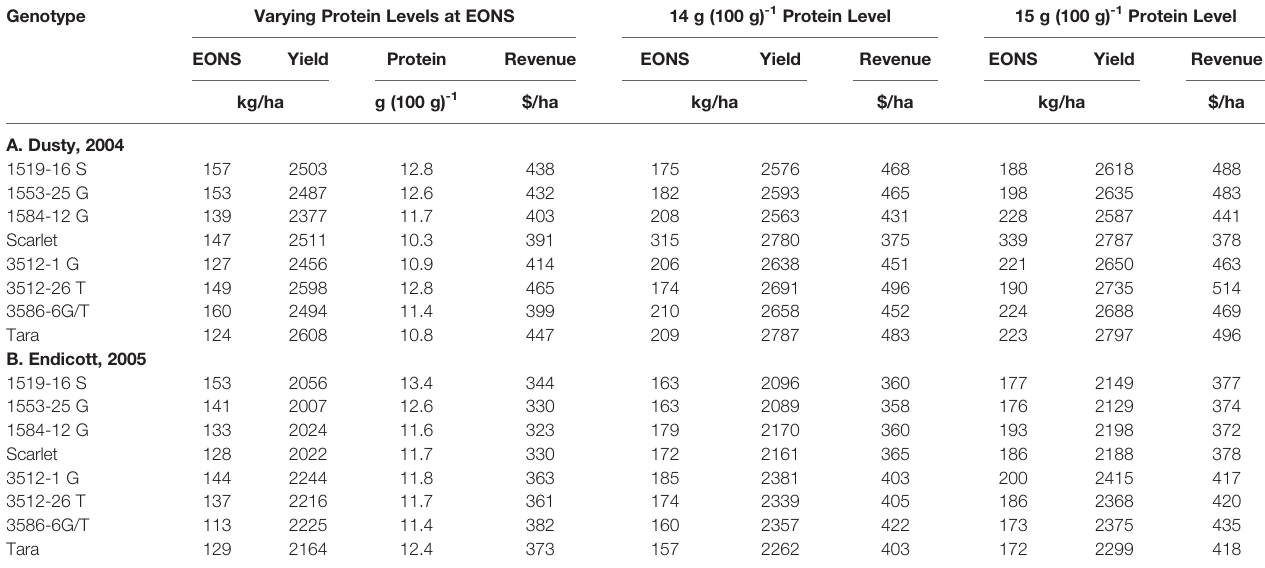
TABLE 2 | Grain protein and net revenue generated from EONS and yields described in Table 1 , and higher EONS required to generate higher net revenues calculated when meeting 14 and 15 g (100 g) -1 protein goals as protein price premiums are